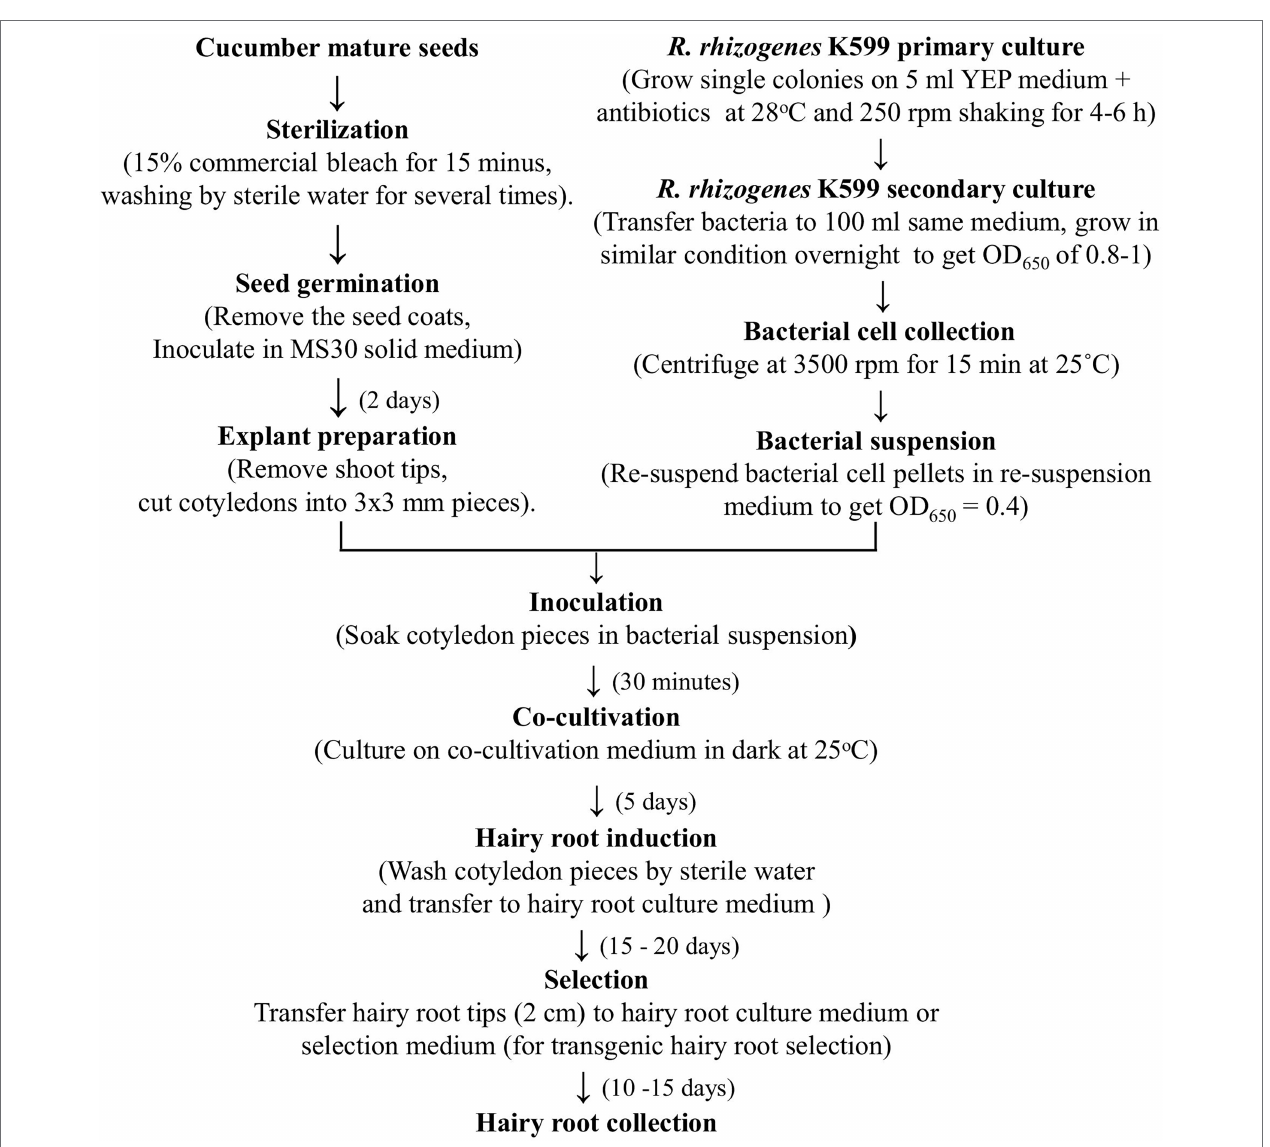
FIGURE 3 | The procedure for cucumber hairy root induction using